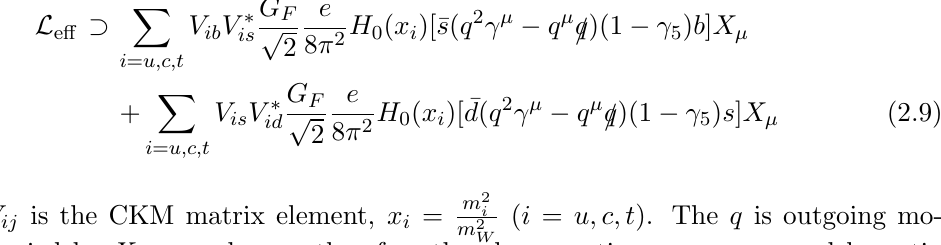
0 + X ) and Br( K + (cid:25) + + X ) from kinematic mixing (cid:15) (cid:13)X between X L ! (cid:25) ! (cid:25) + + X ) 5 : 6 10 (cid:0) 8 ! (cid:21) (cid:2)